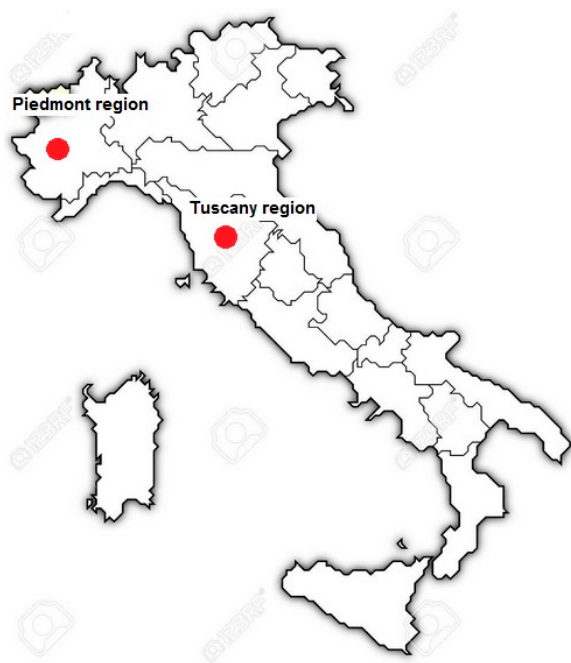
Figure 2. Location of participatory forums at sub-national level.